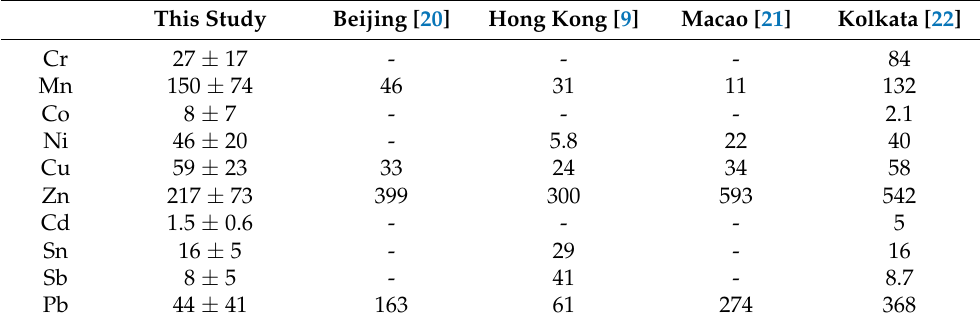
Table 3. Concentration of heavy metal elements in the PM 2.5 samples obtained from different regions (ng/m 3 ). This Study Beijing [20] Hong Kong